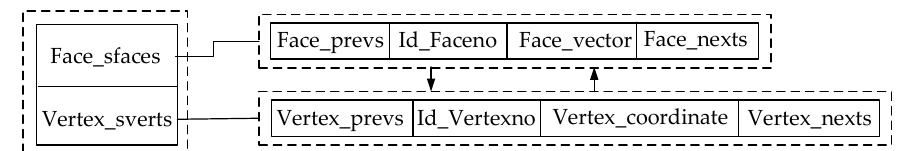
Figure 3. Vertex–face data structure.